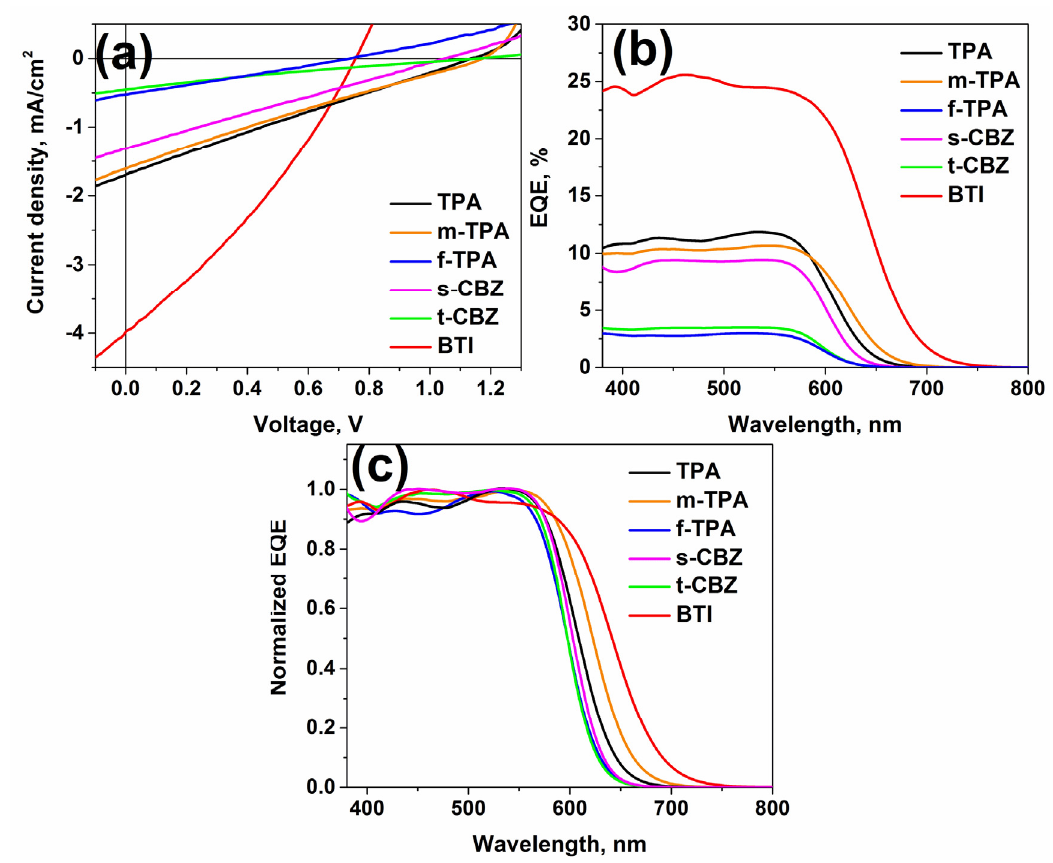
Figure 7. J-V curves under AM1.5G illumination (100 mW/cm 2 ) ( a ), EQE spectra ( b ) and normalized EQE spectra ( c ) for SC OSCs.